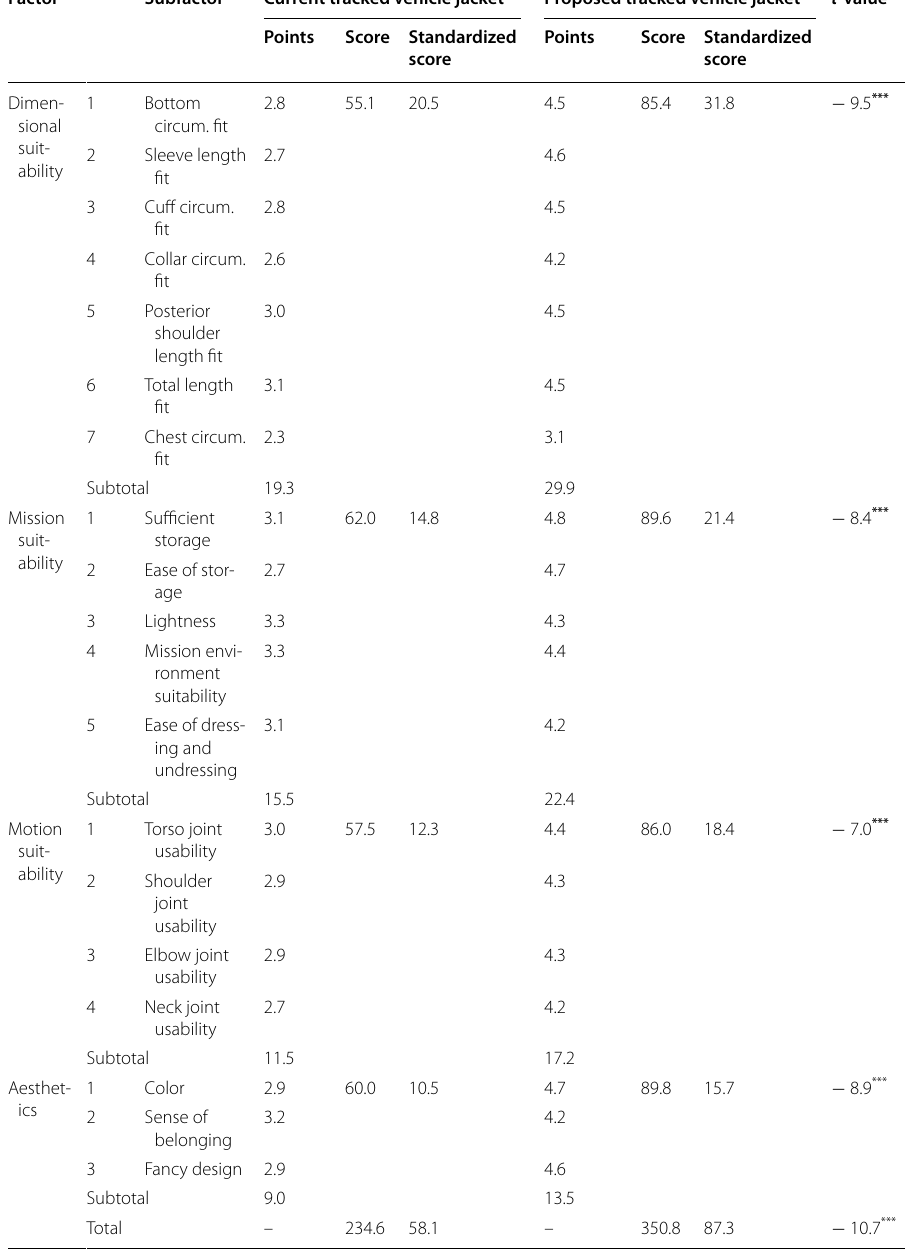
Total evaluation score for the current tracked vehicle jacket